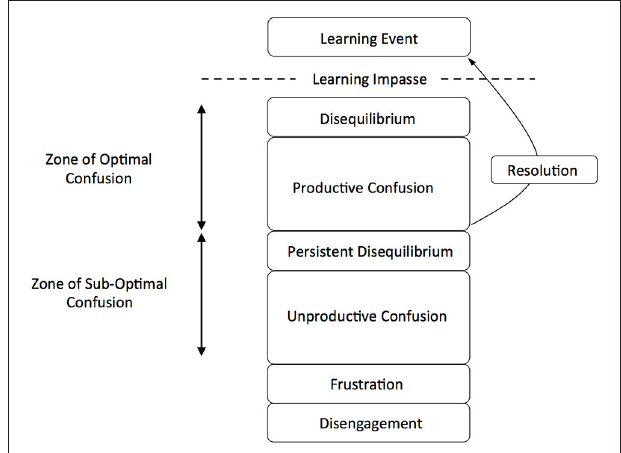
FIGURE 1 | Conceptual framework for the zones of optimal and sub-optimal